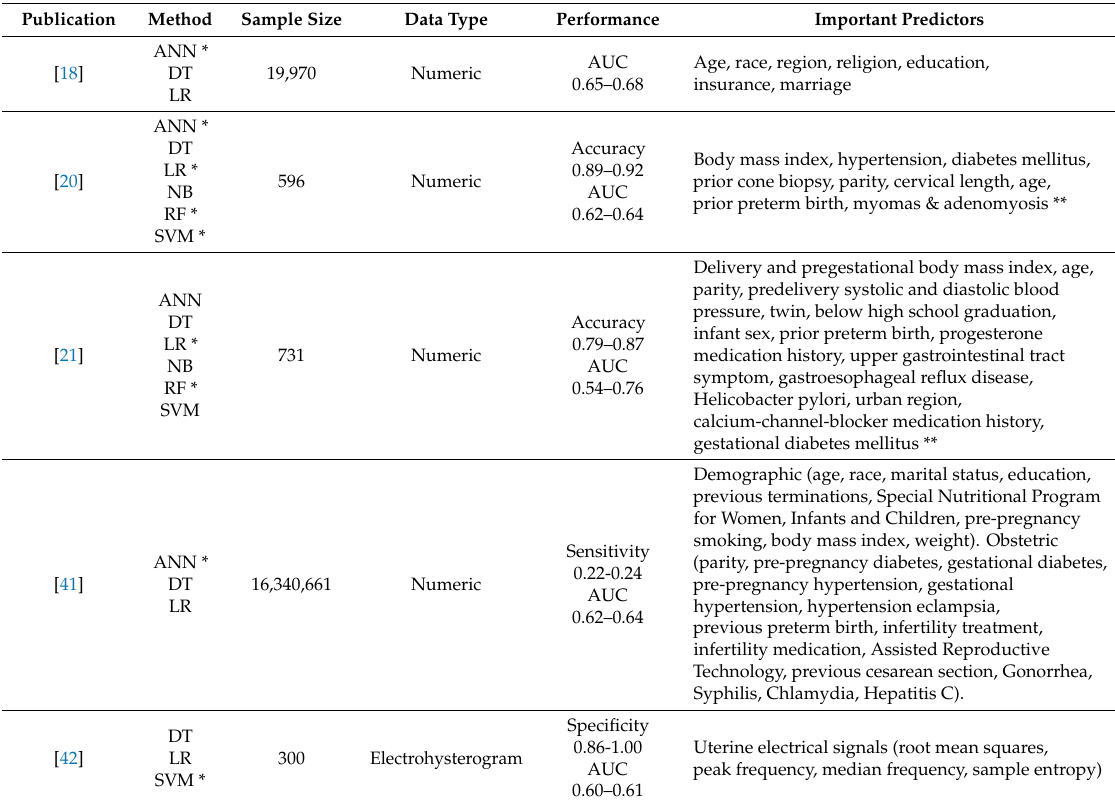
Table 1. Summary of